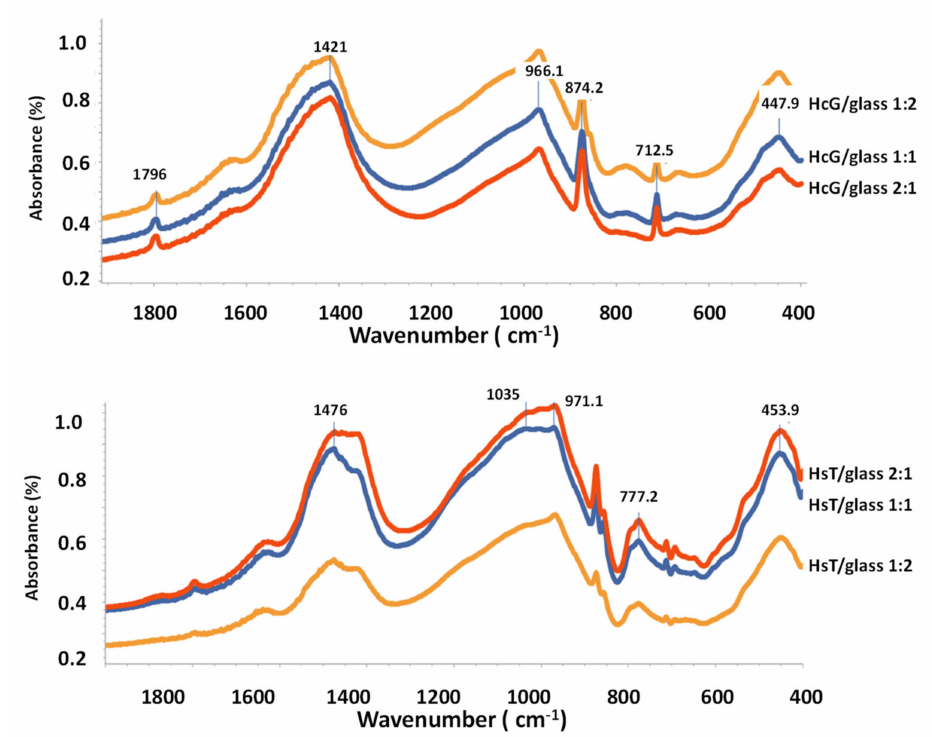
Figure 7. FT-IR analysis at 90 days. ( Up ) HcG samples. ( Down ) HsT samples.